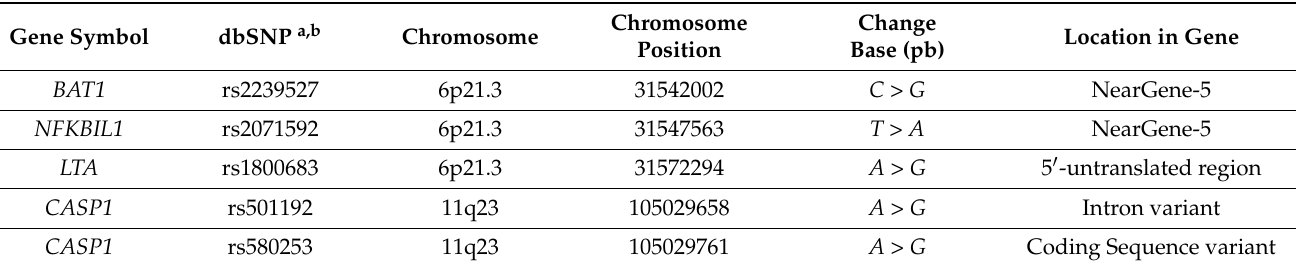
Table 1. Information on the gene polymorphism